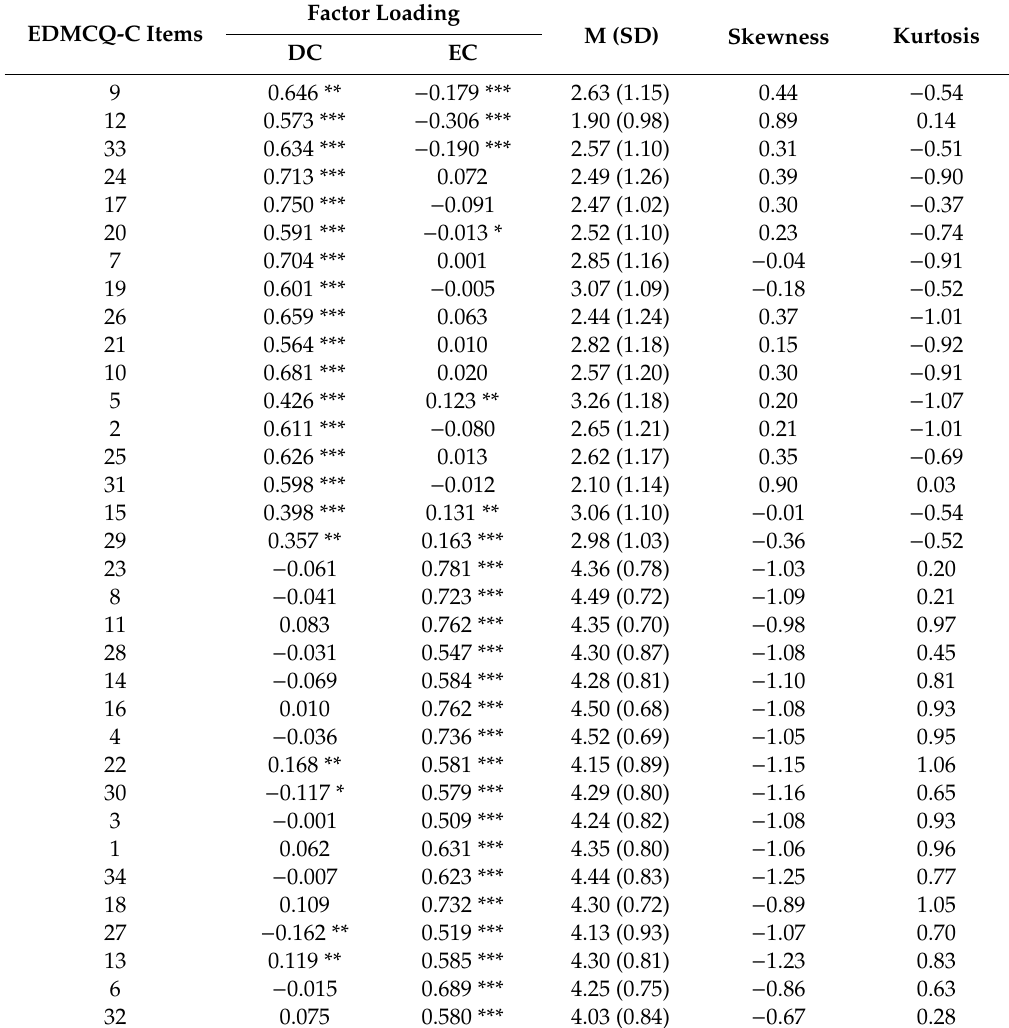
Table 3. Items, standardized factor loadings (FL) for EDMCQ-C re-test (group